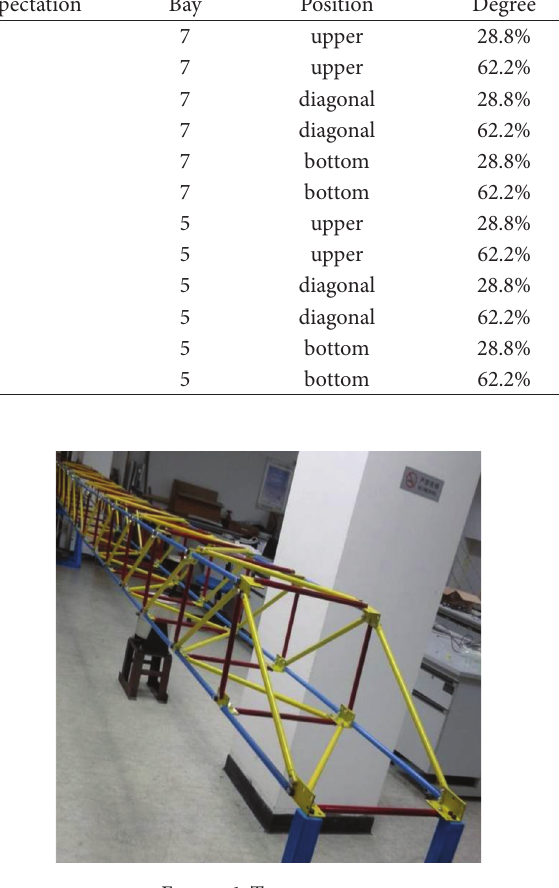
Figure 1: Test structure.